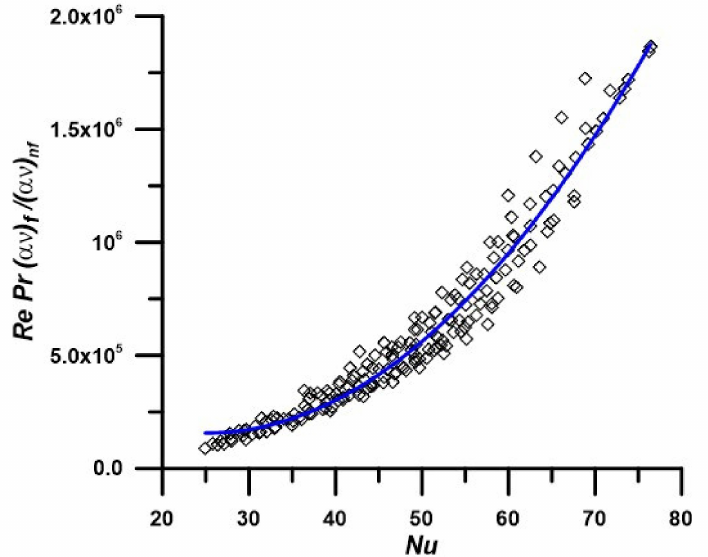
Figure 9. Average Nusselt number at different nanofluid properties depending on temperature and nanoparticle